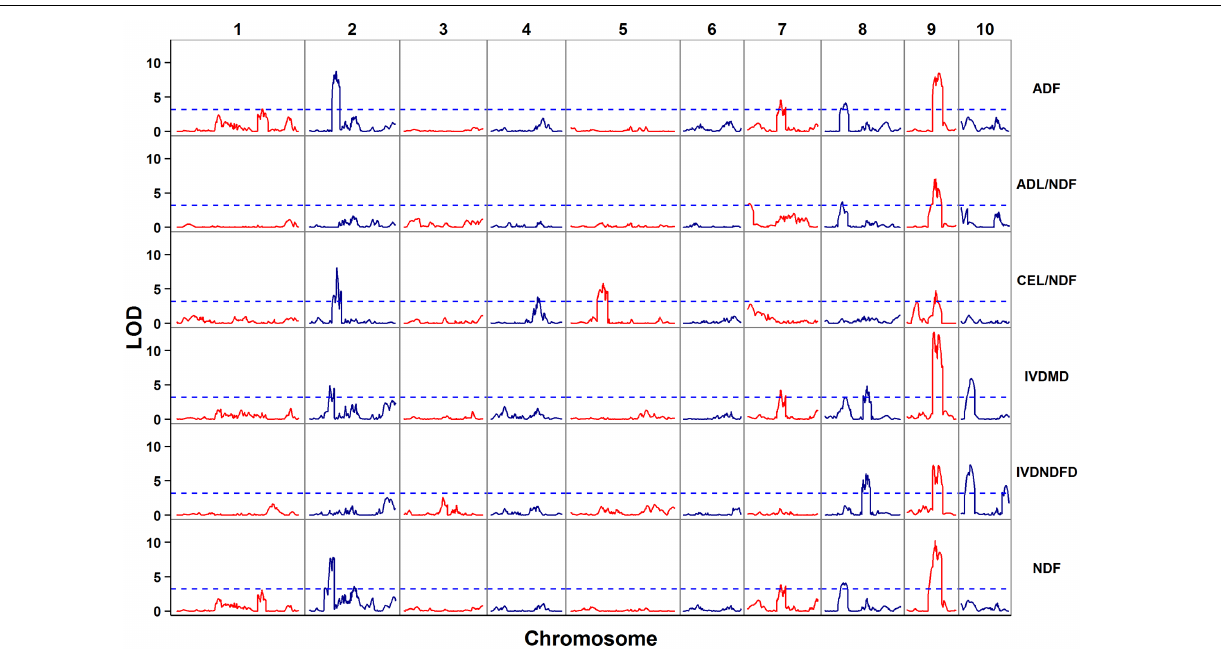
digestibility trait, which ranged from 0.49 to 0.96